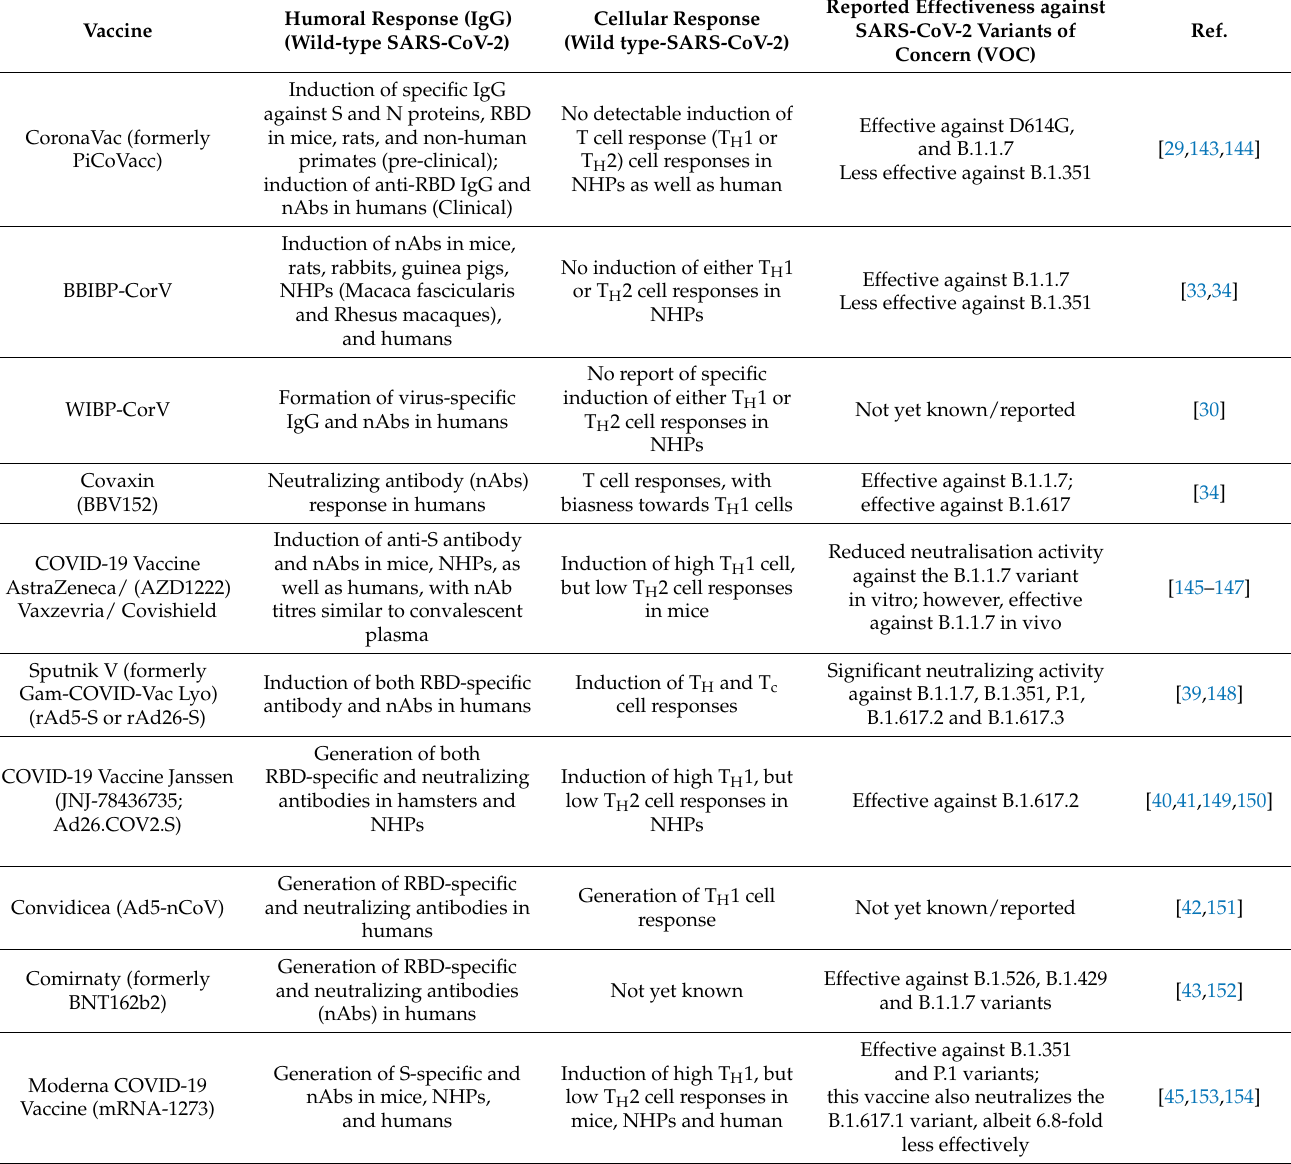
Table 3. Important approved vaccines and reported immune